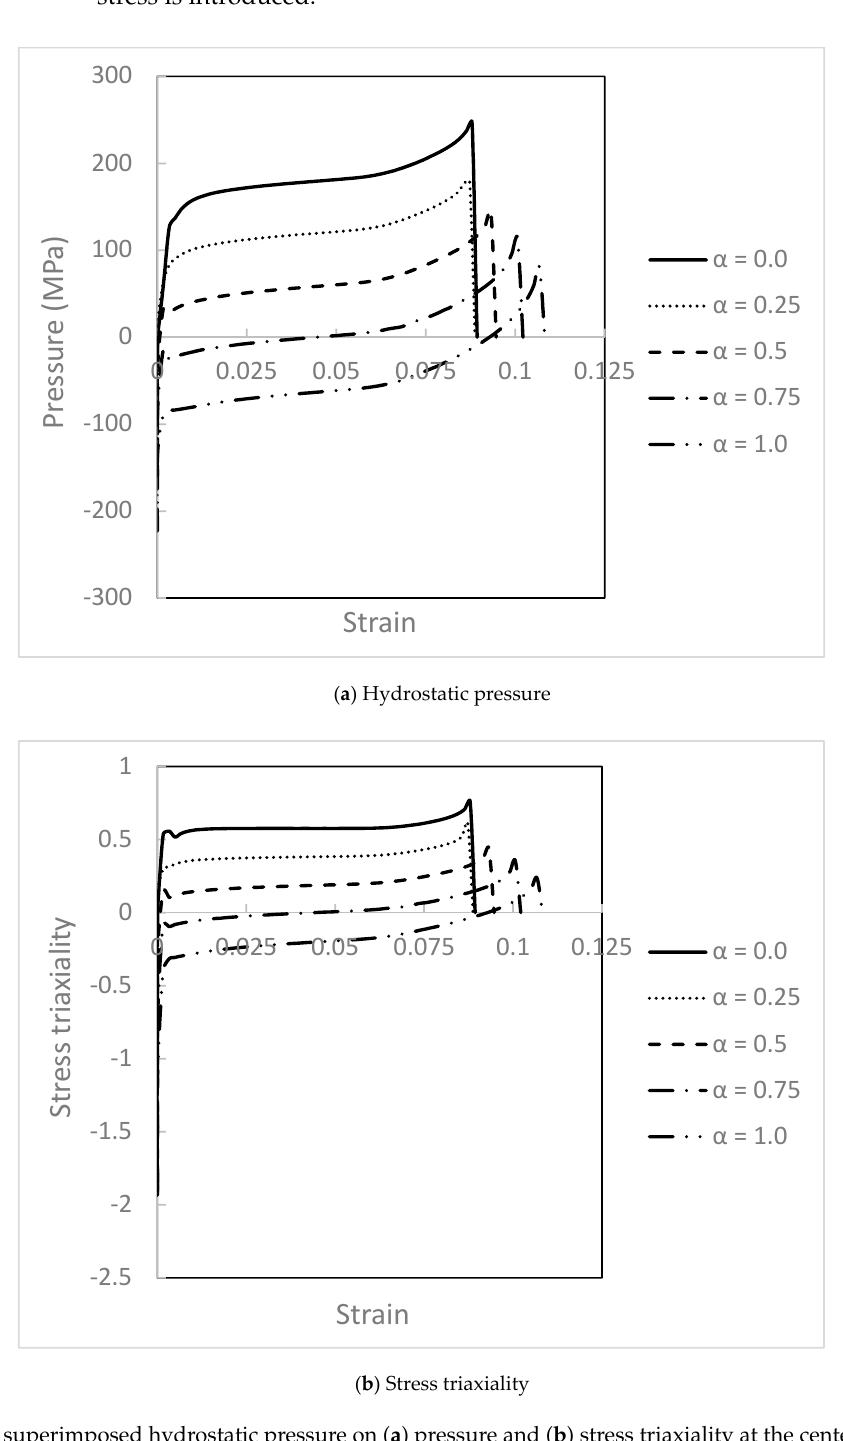
Figure 9. Effect of superimposed hydrostatic pressure on ( a ) pressure and ( b ) stress triaxiality at the center of the specimen. The effect of superimposed double-sided pressure on the formability of a biaxially